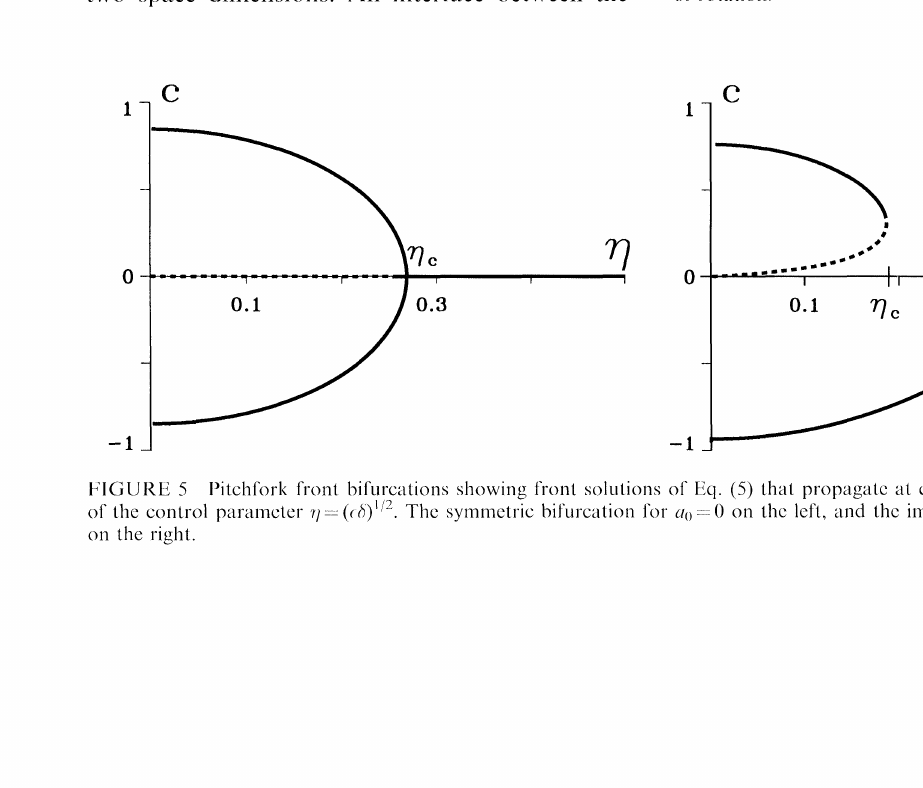
FIGURE 6 A rotating spiral wave obtained by numerical integration of (5) for rl<rlc. The white and grey domains represent the up and down states, respectively. The thick line is the u--0 contour which represents the interface location. The thin line is the v--0 contour which contains information about the direction of propagation; it always lags behind the u---0 contour. The crossing point of the two lines is the center of rotation.